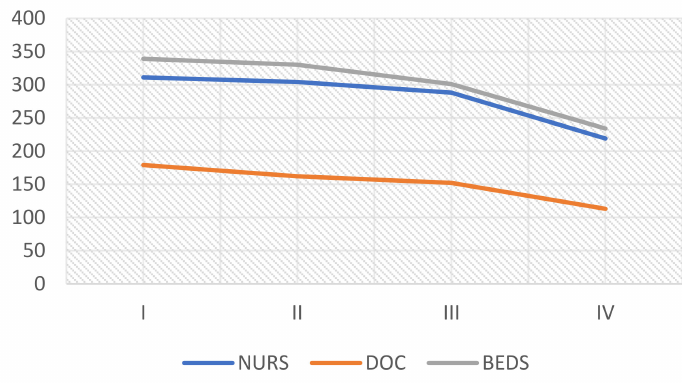
Figure 4. Mean EEC and TEC according to climate zones.